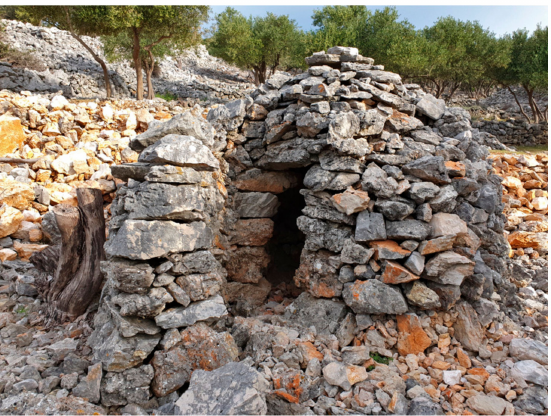
Figure 25. Besides being rare, dry stone shelters with round plans and stone roofing differ among themselves (Tanja Kremeni´c,